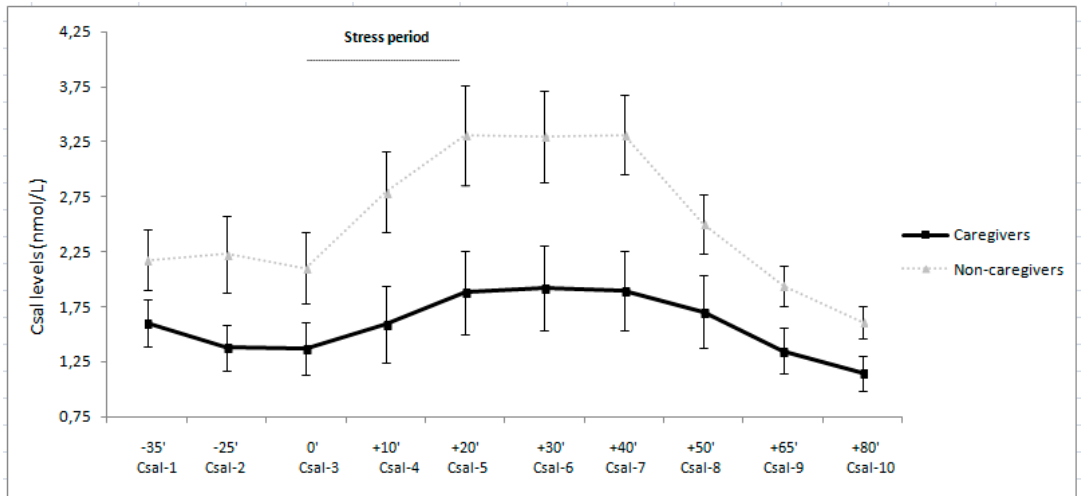
Figure 1. Estimated marginal means and standard errors of means of salivary cortisol (Csal) levels in caregivers and controls.